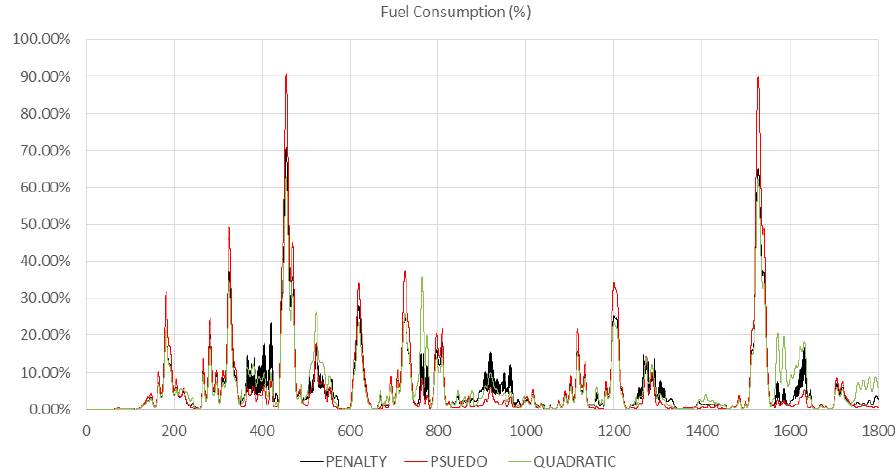
Figure 21. Fuel Consumption Time History Compared to Maximum Capacity by Three Different Thrust-Allocation Algorithms.